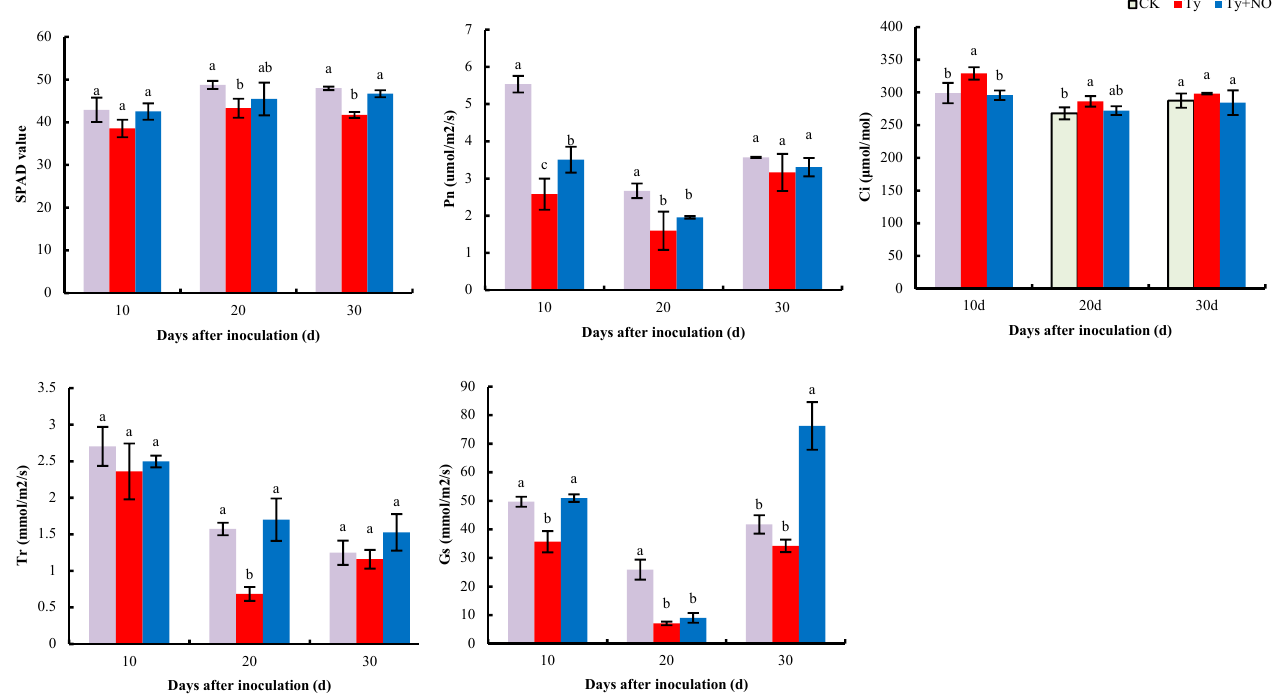
Figure 11. Regulation of antioxidant and defense enzyme activities by exogenous NO in diseased plants. Different lowercase letters indicate significant differences between treatments, p < 0.05. Same below.